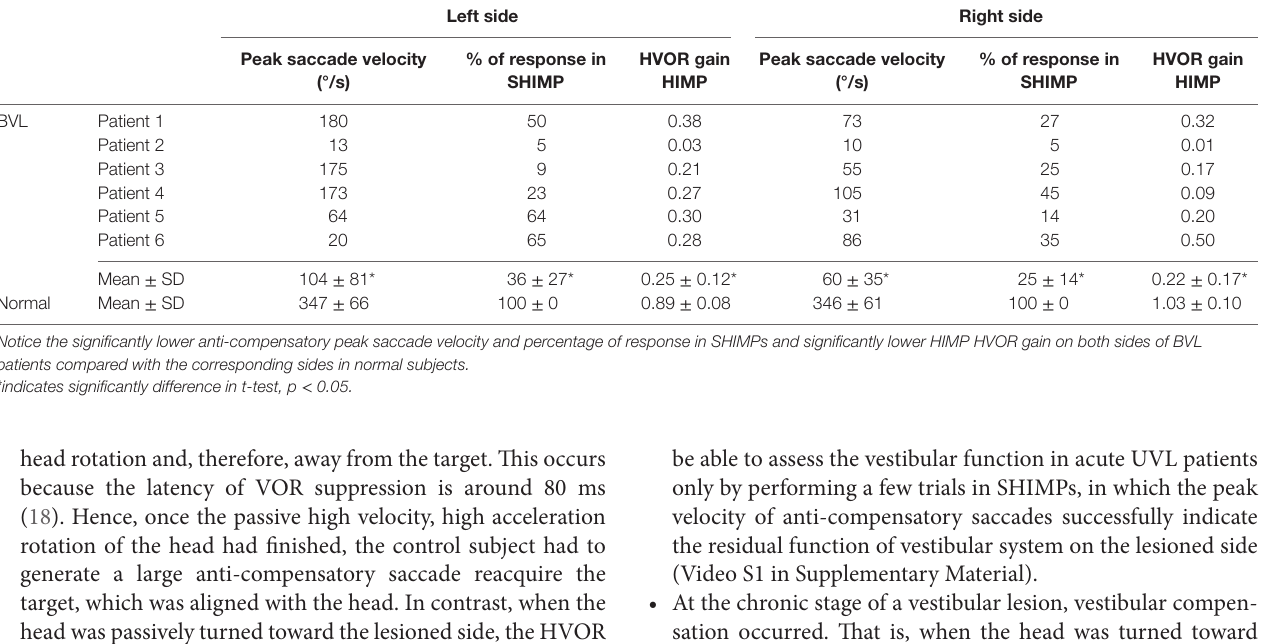
TaBle 3 | Peak saccade velocity, percentage of response in shiMPs, and hiMP VOr gain in both sides of BVl patients and normal subjects. left side right